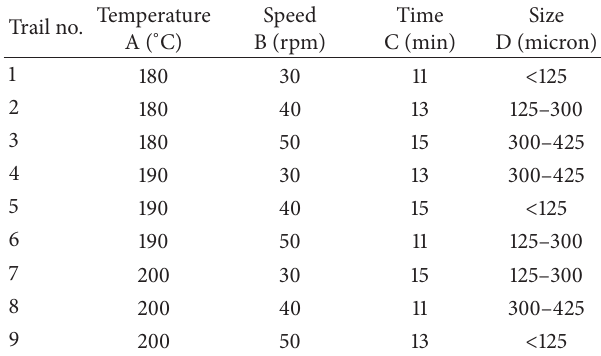
Table 1: Properties of thermoplastic polyurethane (TPU).